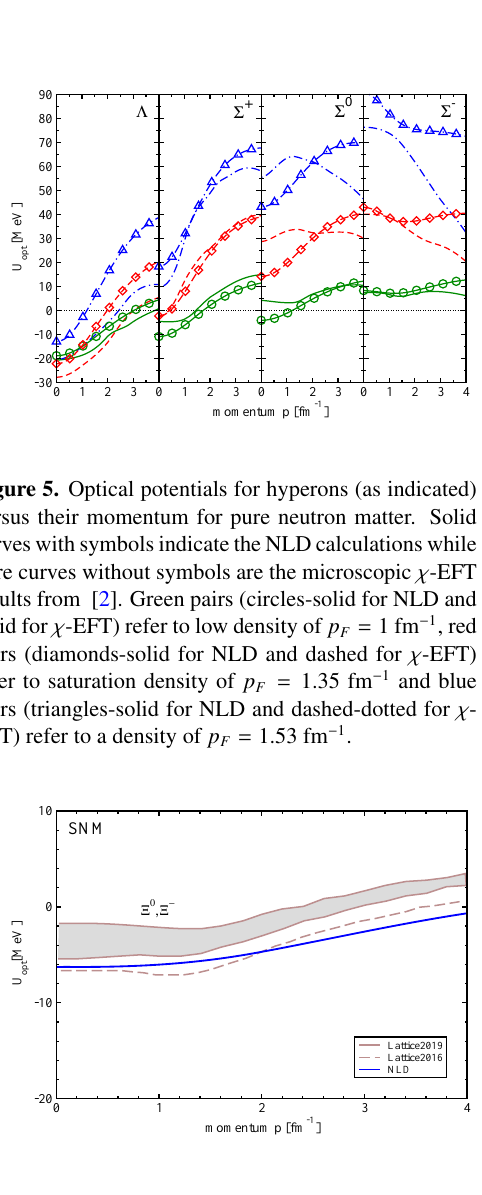
Figure 6. Optical potential of cascade hyperons versus their momentum for symmetric nuclear matter (SNM) at saturation density. The solid curve indicates the NLD predictions while the dashed curve and the gray band re- fer to recent Lattice calculations from Refs. [4].